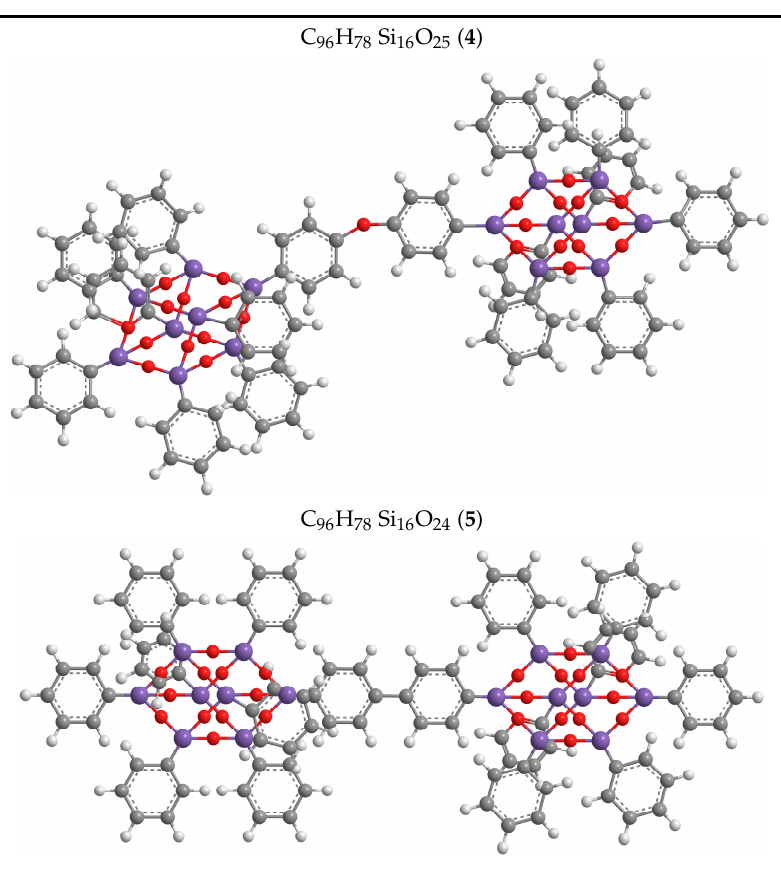
Table 2. ( 4 ) and ( 5 ) dumbbell-shaped octaphenyl POSS structures, with aromatic bridge, used in PS nanocomposites.